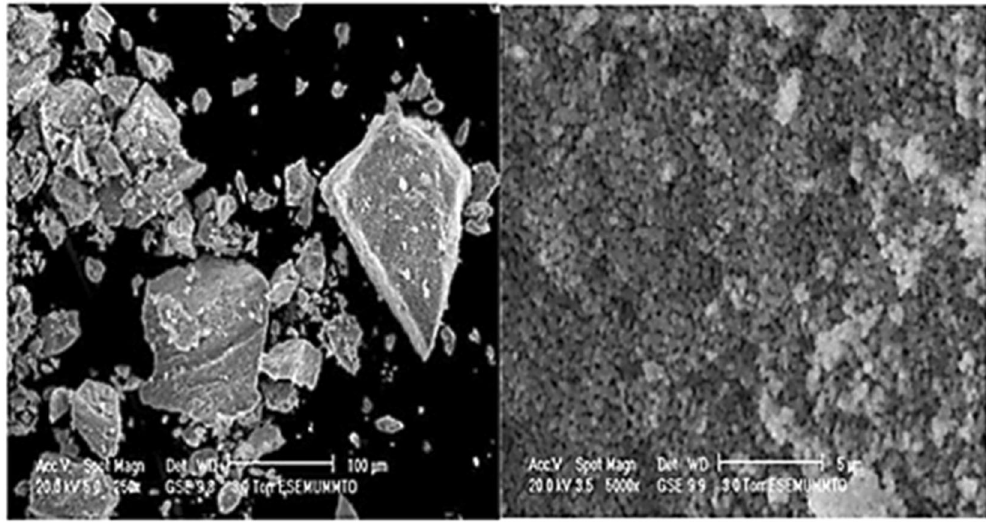
Fig. 3 Flecks of aggregates formed during electrocoagulation. Flecks showed by scanning electron microscope (SEM) after 60 min of EC 153